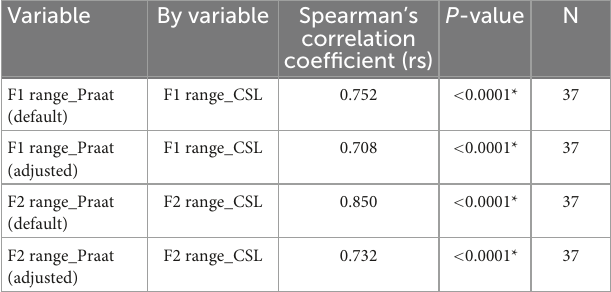
TABLE 5 Spearman’s rank correlation of F1 and F2 ranges of the five Japanese vowels calculated by Computerized Speech Lab (CSL) to those calculated using the default and adjusted settings of